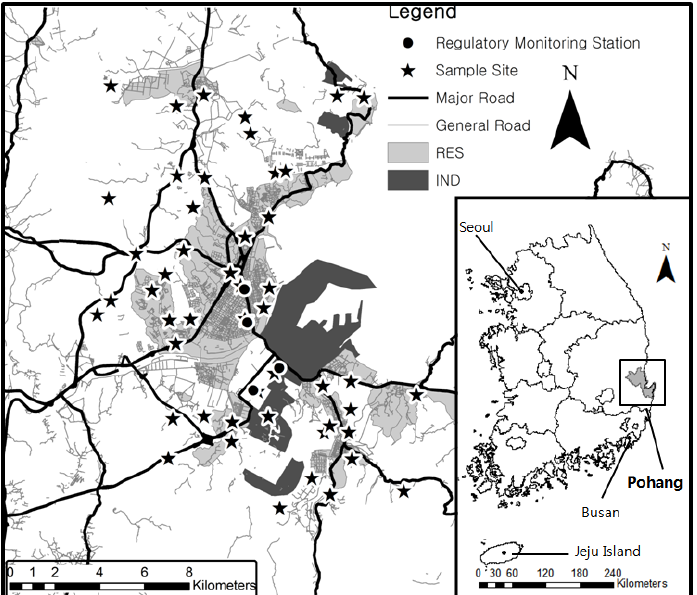
Figure 1. Locations of sampling site in Pohang city, South Korea (RES: residential area; IND: industrial